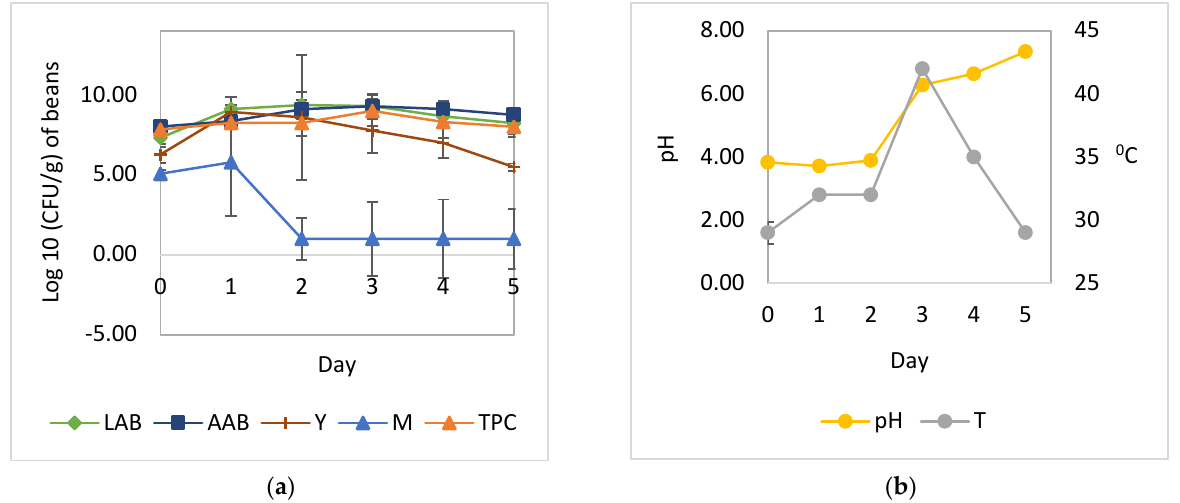
Figure 4. Microbial growth patterns and changes in pH and temperature during the fermentation of cocoa beans with the addition of L. plantarum HL-15, C. famata HY-37, Acetobacter spp. HA-37, and A. niger YAC-9: ( a ) growth of yeast, LAB, AAB, and mold; ( b ) temperature and pH. LAB, total lactic acid bacteria; AAB, total acetic acid bacteria; Y, total yeast; M, total mold; TPC, total plate count; pH, pH pulp; T, temperature.